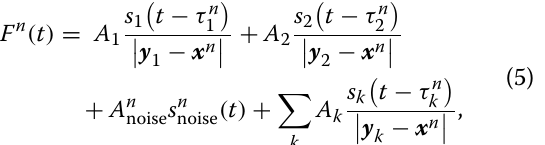
expected, the synthetic CCs without fumarolic signals show small symmetric peaks in the correlation response (Test 1: Fig. 4b1, c1). The peak values are as small as the minor peak for the observed SI-array CC (Fig. 4b, c). In the test, including a synthetic ISC signal with an adequate thetic array CCs are smaller than the observation,